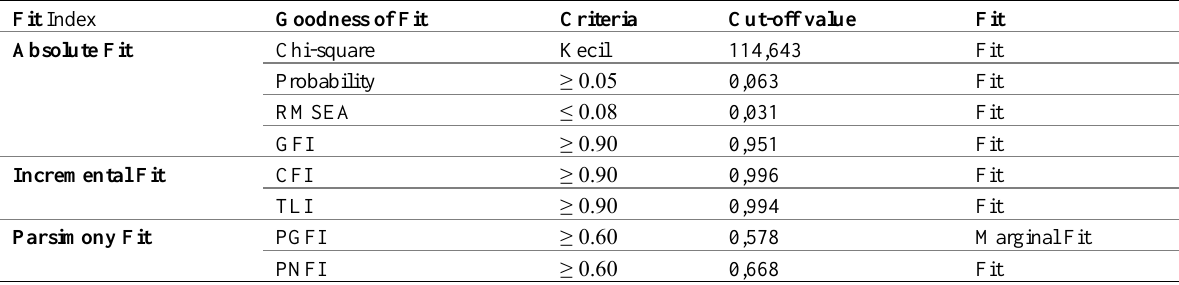
Table 3: Final GOF Test